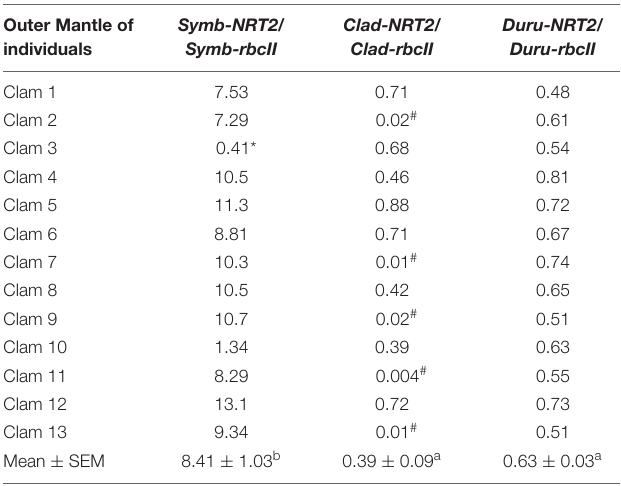
TABLE 4 | Ratios of the transcript levels of nitrate transporter 2 ( NRT2 ) to that of form II ribulose-1,5-bisphosphate carboxylase/oxygenase (rbcII) from Symbiodinium (Symb-NRT2/Symb-rbcII), Cladocopium (Clad-NRT2/Clad-rbcII), and Durusdinium (Duru-NRT2/Duru-rbcII) obtained from the outer mantle of Tridacna squamosa ( n = 13).